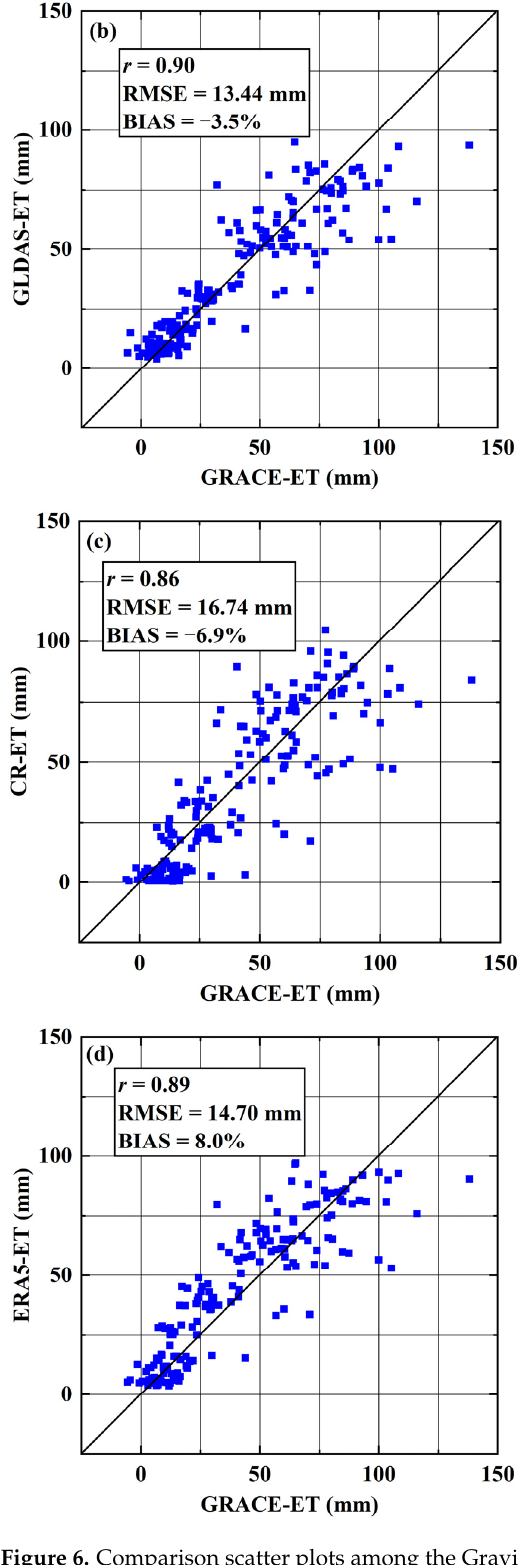
Figure 6. Comparison scatter plots among the Gravity Recovery and Climate Experiment (GRACE) evapotranspiration (ET) and other products in the Yellow River Basin. GRACE—Gravity Recovery and Climate Experiment; ( a ) GLEAM—Global Land Evaporation Amsterdam Model; ( b ) GLDAS— Global Land Data Assimilation Systems; ( c ) CR—Complementary Relationship; ( d ) European Centre for Medium-Range Weather Forecasts Reanalysis 5 (ERA5).